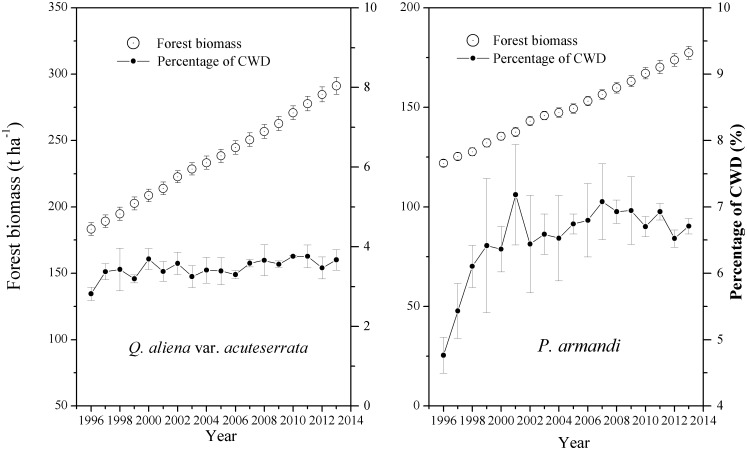
The forest biomass and the percentage of CWD to the forest biomass (the mass of living trees, shrubs, herbs, litter and CWD) in the P. armandi and Q. aliena var. acuteserrata forests from 1997–2013.The forest biomass data sources are Chen and Peng [60] and the unpublished Qinling long-term ecological monitoring database. Errors bars are based on plot as experimental unit (N = 3).